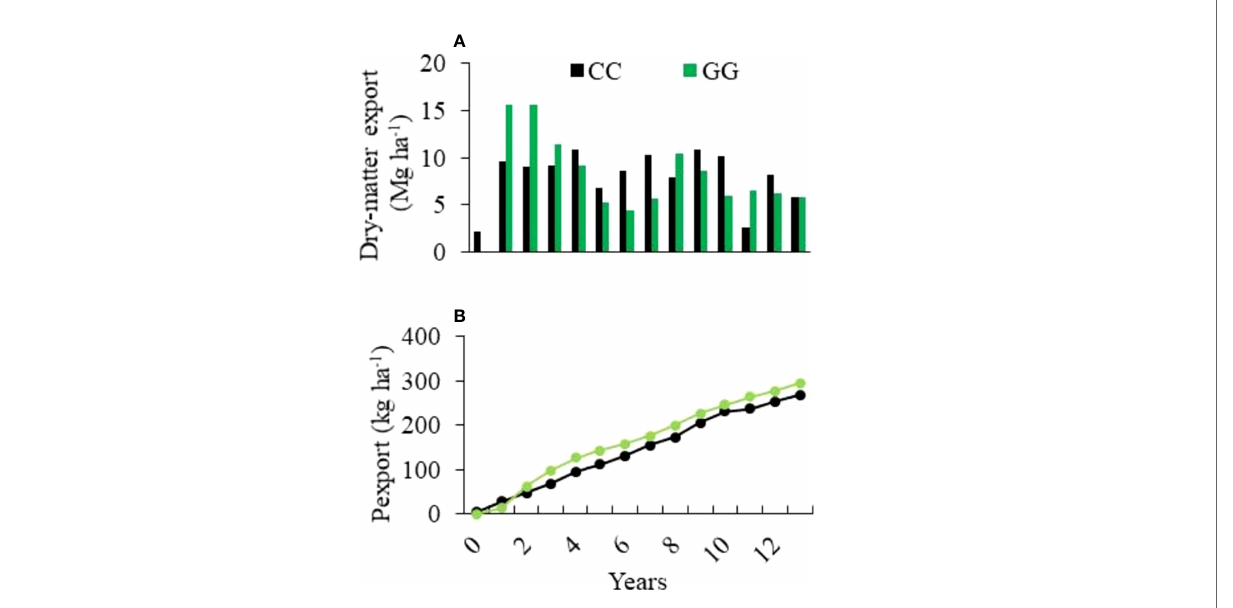
FIGURE 2 | Exportation of (A) annual dry matter and (B) accumulated phosphorus from the experimental fi eld over 13 years of cultivation. CC-permanent conventional crop rotations and GG-permanent